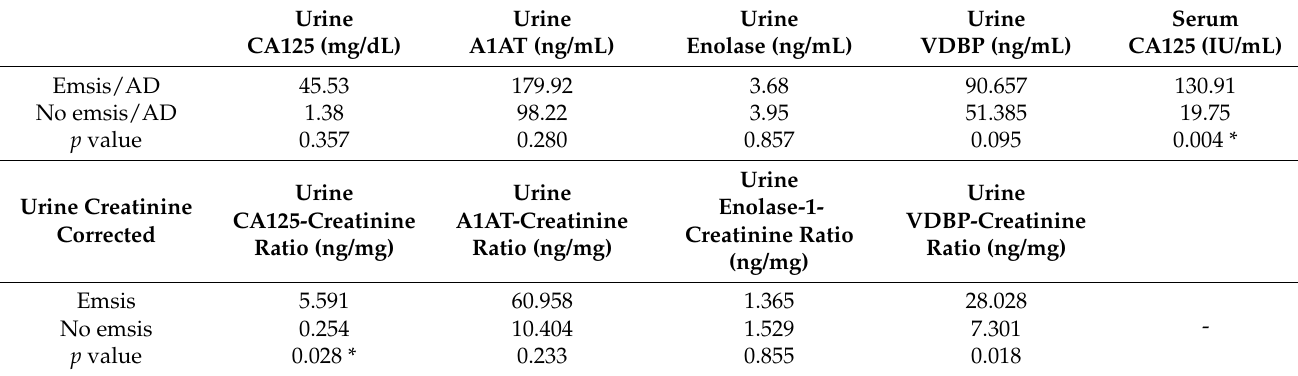
Table 3. The median values comparison of examined biomarkers and the urine-creatinine correction in different endometriosis